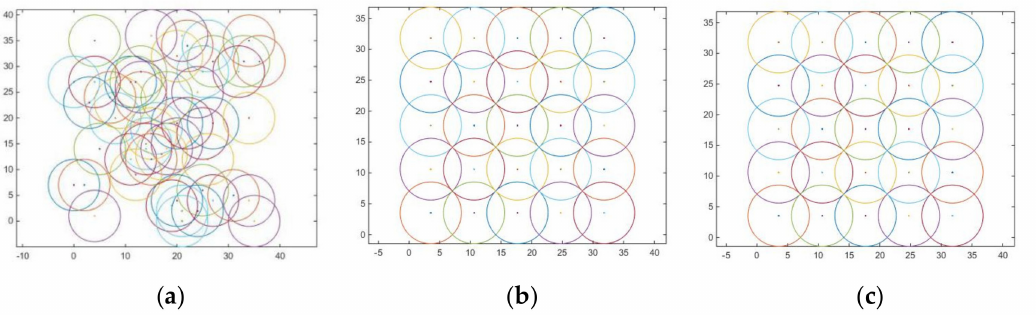
Figure 21. Schematic diagram of nodes tending to stabilize. ( a ) Initialization; ( b ) after time has elapsed; ( c ) stable state. Table 3. Parameter setting. Key Parameters